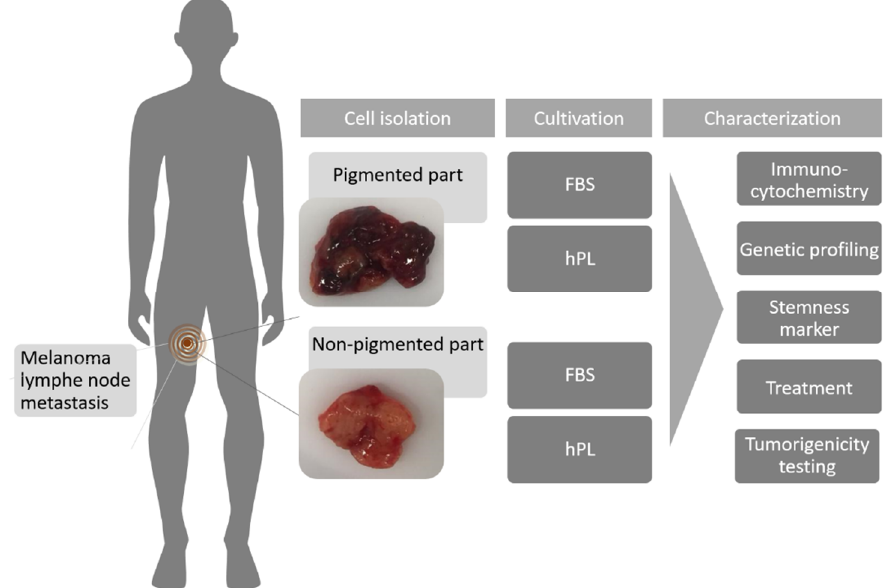
Figure 1. Overview of the experimental procedures. The location of the lymph node metastasis is illustrated, as well as the morphology of both areas (pigmented and non-pigmented). Furthermore, information about the cultivation conditions and individual steps in characterization are provided.